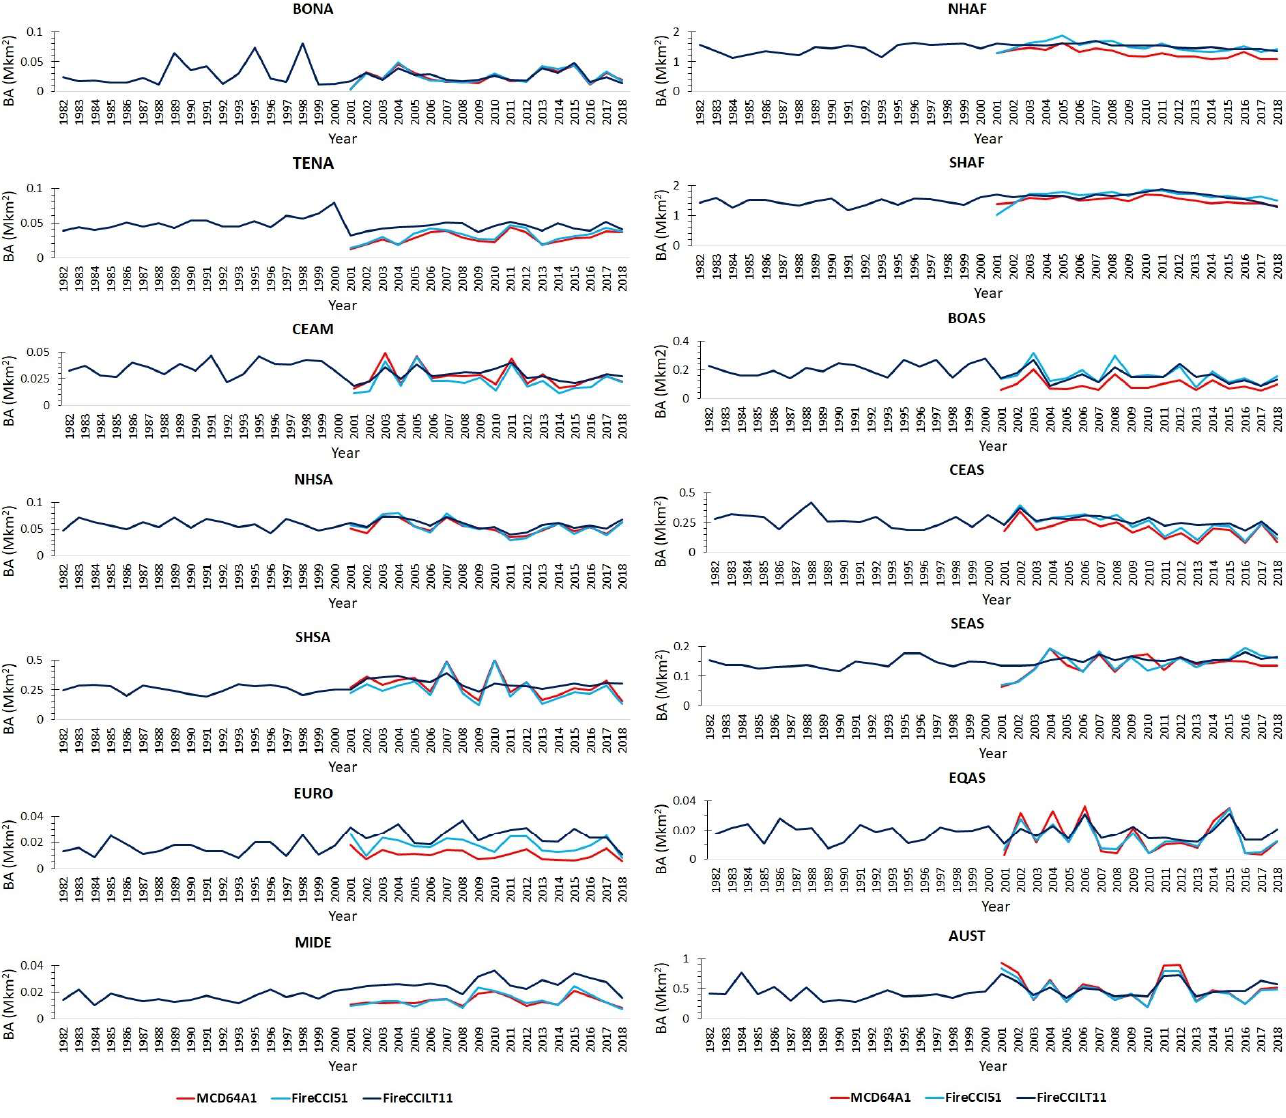
Figure 1. Annual BA trends of MCD64A1, FireCCI51 and FireCCILT11 in the different continental regions from Ot ó n et al.